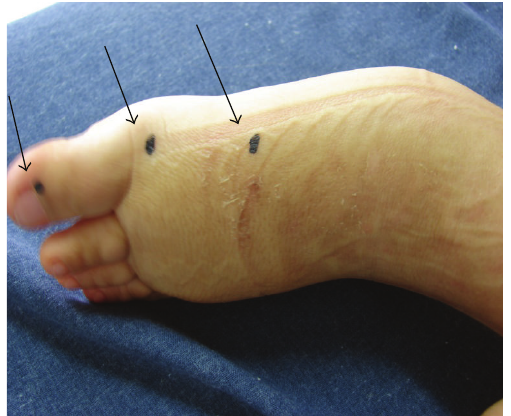
Figure 1: Points of measurement of the perimetry of the foot.